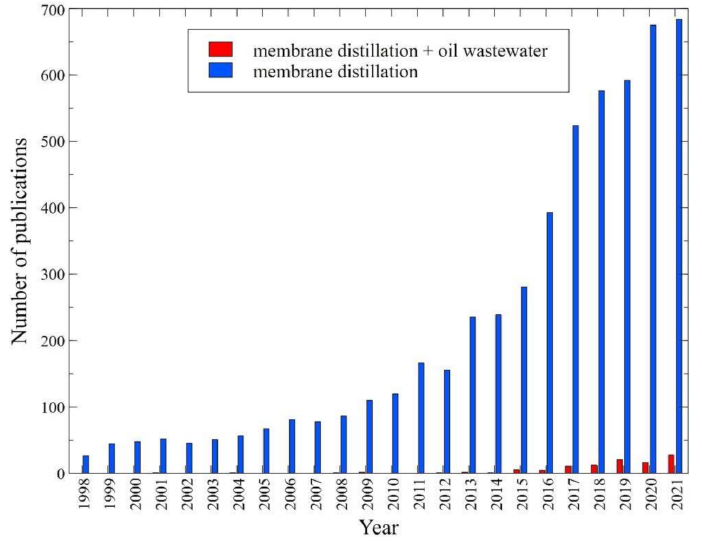
Figure 1. Number of publications focused on the MD process and wastewater treatment. Scopus, data retrieved: 22 February